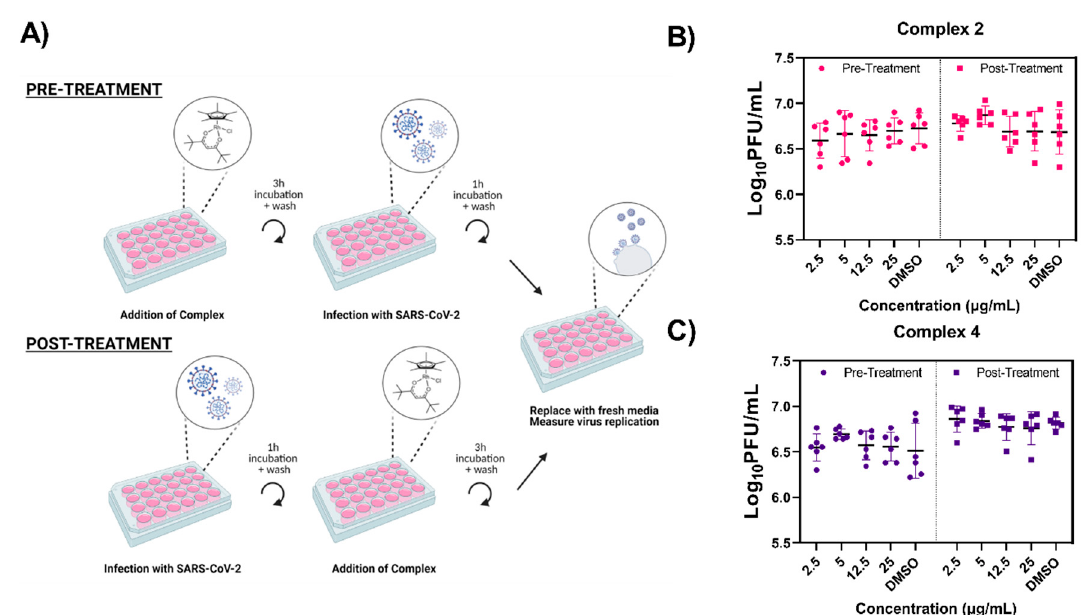
Figure 6. Organometallic complexes lack activity after prophylactic and therapeutic treatment. Vero E6 cells were treated with either complex 2 ( B ) or 4 ( C ) and infected (MOI = 0.1) with SARS-CoV-2 as displayed by the treatment schematic ( A ). Following infection or post-treatment, complete medium was added and supernatant was collected 24 hpi. Infectious SARS-CoV-2 titers were quantified via plaque assay and data are reported as Log 10 PFU/mL titers. Data are shown from two biological experiments conducted in triplicate. Individual data points are displayed and error bars represent the standard deviation.